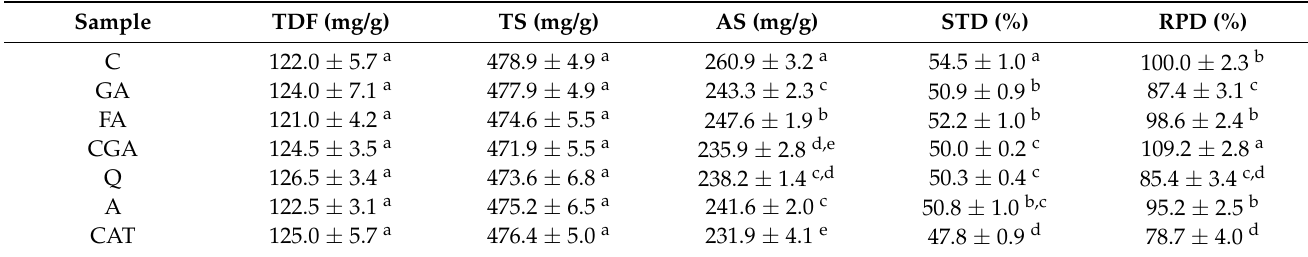
Table 3. Effect of phenolic compounds on nutrient contents and in vitro